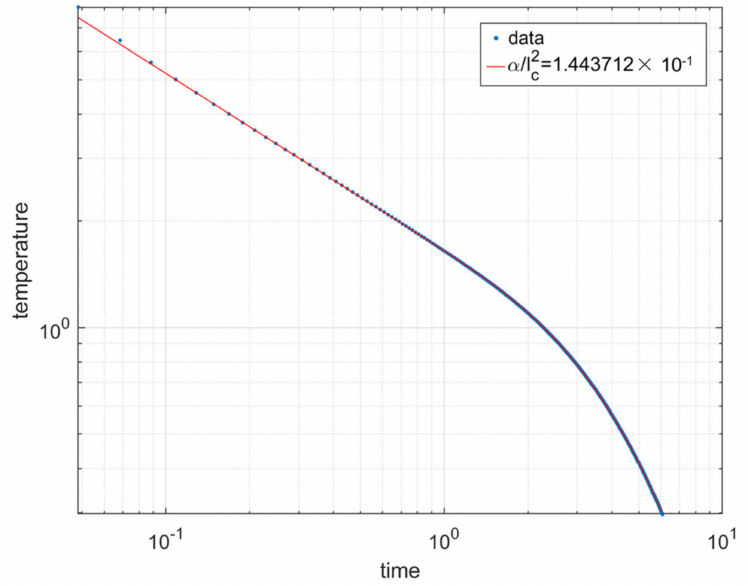
Figure 4. Log-log representation of the spatial average of the surface temperature in time given as an example of the processed output. The red line is the fit curve calculated on the experimental data (blue